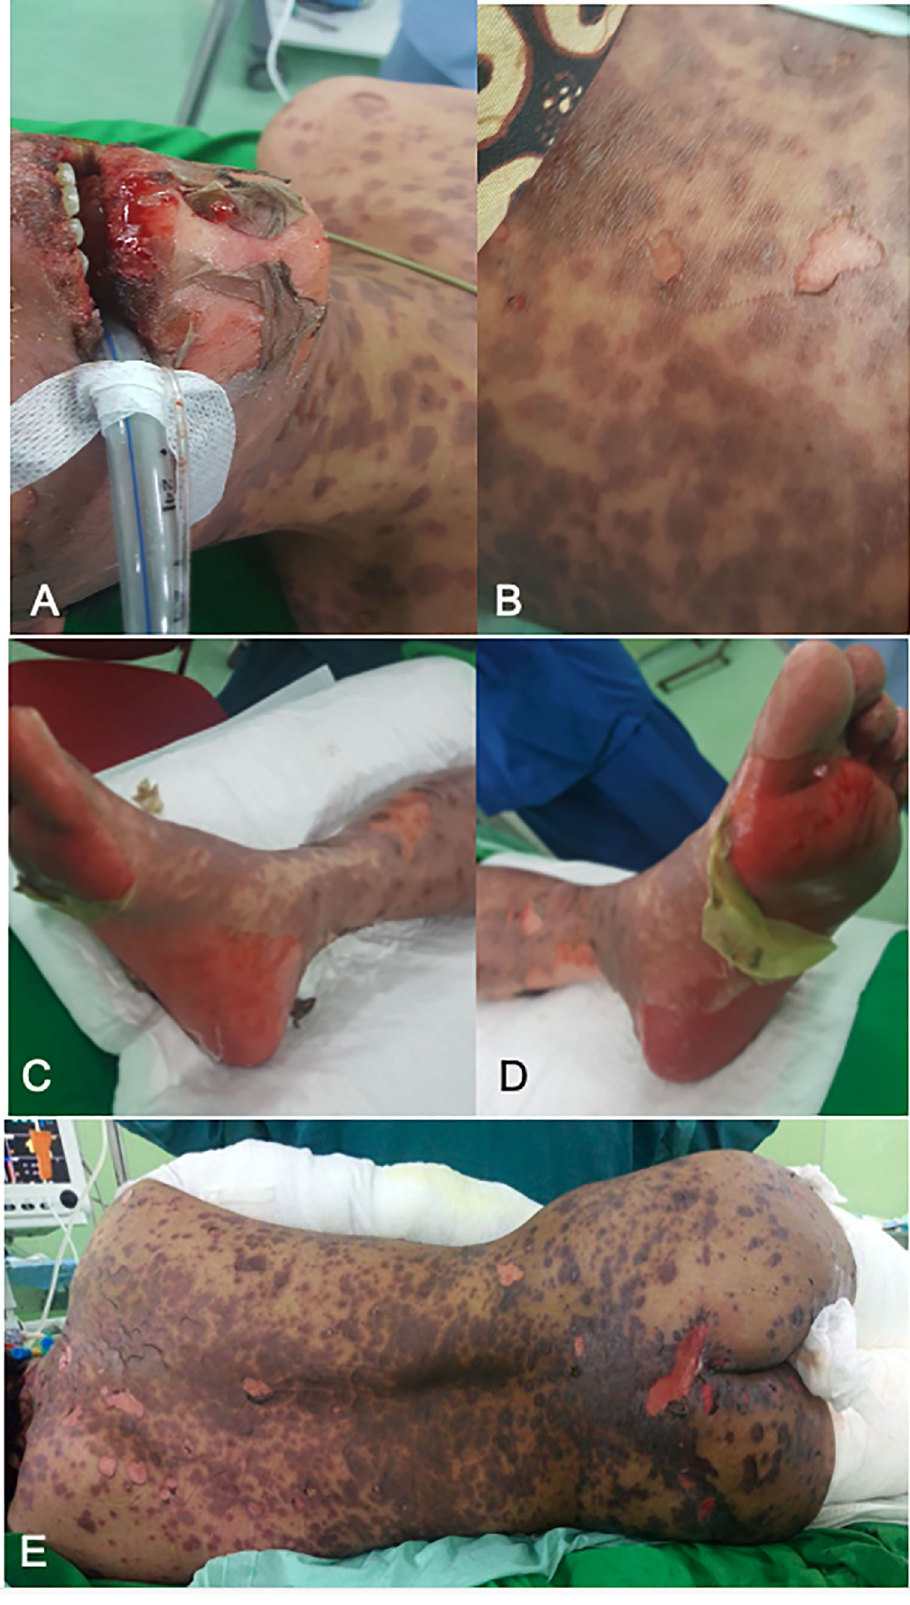
Figure 1. Skin abnormalities of patient before therapy in the facial and colli region (A), the trunk region (B), bilateral lower extremity et pedis region (C and D), posterior thoracic region (E) showed erythematous macules, bullae, erosions and brownish crusts with a positive Nikolsky